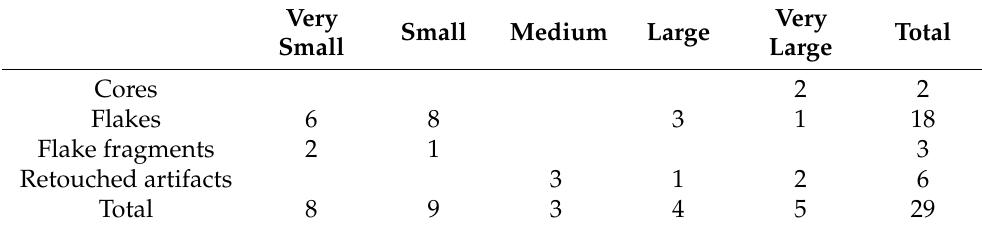
Table 7. Distribution of the artifacts according to technical and size categories.